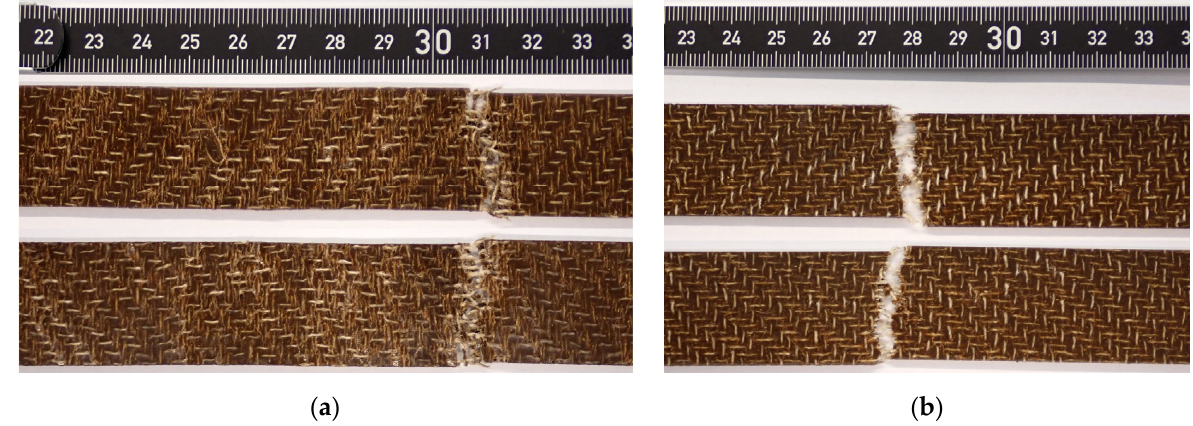
Figure 11. Fracture zones of selected tensile test specimens ( a ) in 0° (weft direction, above front view and below back view); ( b ) in 90° (warp direction, above front view and below back view).